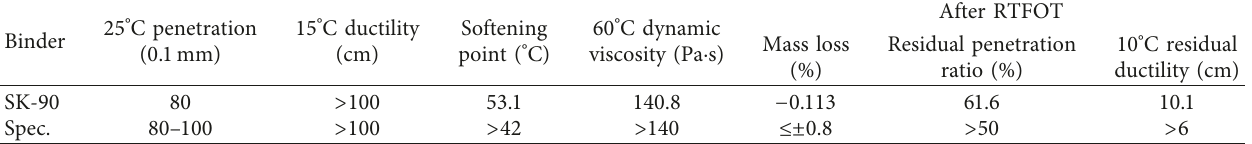
Table 1: Physical properties of SK-90.